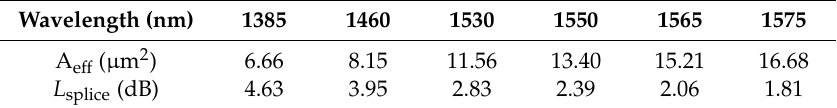
Figure 8. Dispersion and K value ( a ) as well as D R after compensation by using designed microstructure fiber (MSF) ( b ) with wavelength. Table 1. The effective mode area of designed MSF and splice loss with standard single-mode fiber (SMF).